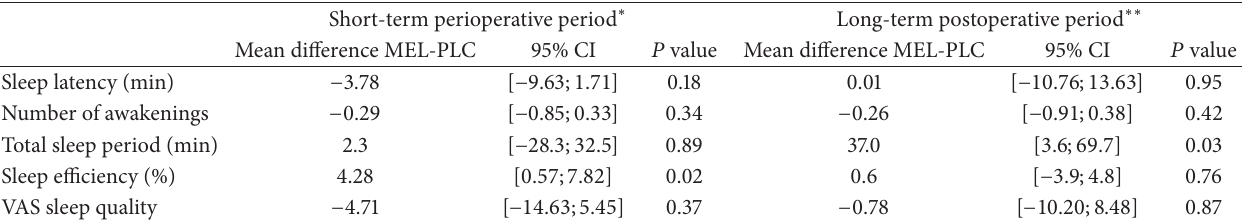
Sleep diary data were calculated as a median for each patient in the 2 time periods. Bootstrapping was used to calculate confidence intervals for the means and 𝑃 values for the difference in means. This was performed using the “smean.cl.boot” function in the “Hmisc” library in R version 3.0.1 (R Foundation for Statistical Software, Vienna, Austria). MEL: